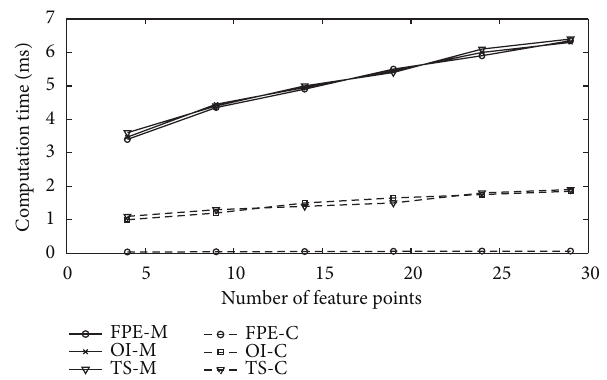
F 7: Computation time versus a number of feature points. “FPE-M”, “OI-M”, and “TS-M” mean that the algorithms are tested in MATLAB language, while “FPE-C”, “OI-C”, and “TS-C” mean that the algorithms are tested in C++